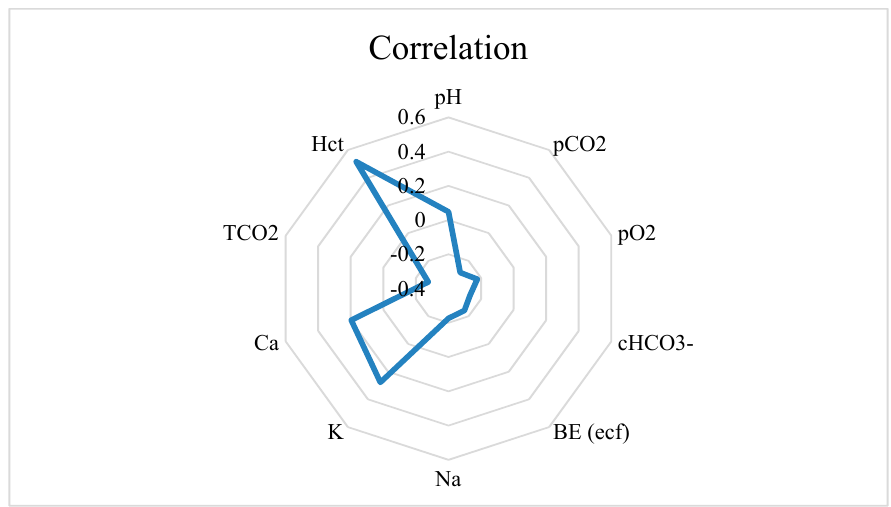
Figure 5. Reticulorumen pH correlations with blood indicators. BE—base excess in blood; PCO2—partial carbon dioxide pressure; PO2—partial oxygen pressure; cHCO3—bicarbonate;